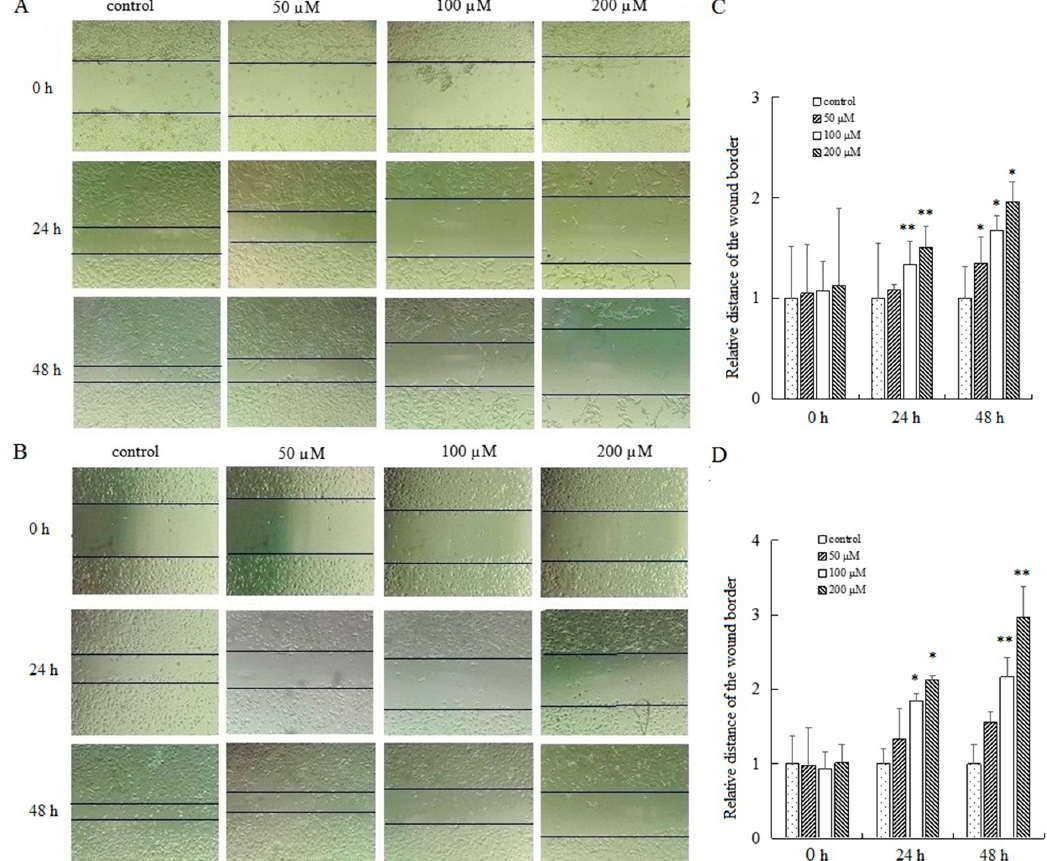
Figure 4. Examination of the motility of HGC-27 and AGS cells by wound healing assay. ( A ) HGC-27 cells; ( B ) AGS cells; ( C ) the relative distances of the wound border in HGC-27 cells; ( D ) the relative distances of the wound border in AGS cells. All experiments were performed three times and expressed as mean ± SD. * p < 0.05 and ** p < 0.01 vs. control group.